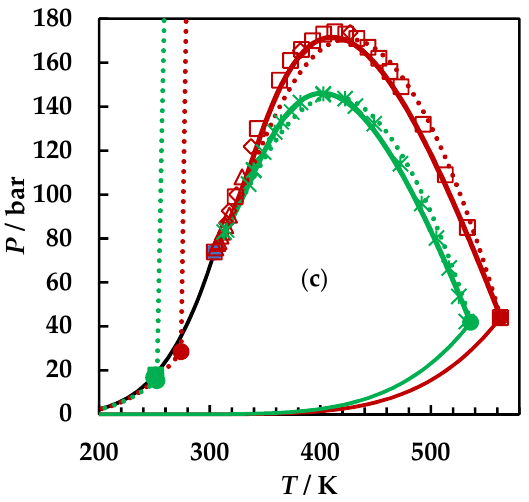
Figure 7. P–T fluid phase diagram of the carbon dioxide (1) + tert -butanol (2) and carbon dioxide (1) + 2-butanol (2) ( a), carbon dioxide (1) + isobutanol (2) and carbon dioxide (1) + 2-butanol (2) ( b ), and carbon dioxide (1) + 1-butanol (2) and carbon dioxide + 2-butanol (2) binary systems ( c ). Experimental data: CO 2 + tert -butanol ( ● , this work; ■, [28]; ▲, [29]; ◆, [30]); CO 2 + 2-butanol ( ✱ , [48]; × , [49]); CO 2 + isobutanol ( ● , this work; ▲, [27]; ◆, [26]); CO 2 + 1-butanol ( ∆ , [52]; □ , [50]; ◊ , [51]). Model results: GEOS (full lines); PR (dotted lines).